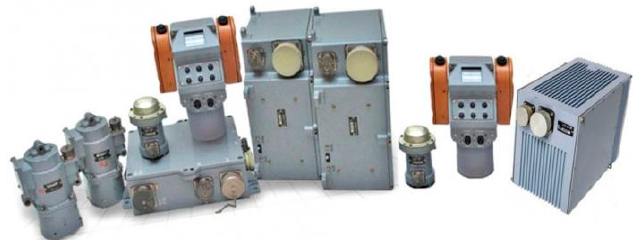
Figure 1. SVU-500 Weapon stabilising system (from left to right: SVU-500, SVU-500-01, SVU-500-3TS, SVU-500-4TS, SVU-500-4TS-01, SVU-500-10P, SVU-500-3TS-01).